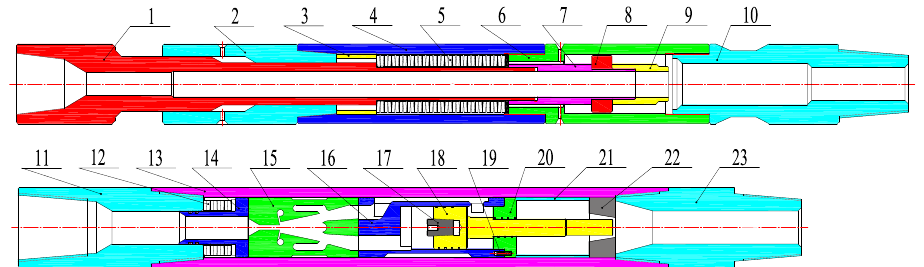
Figure 1. Schematic diagram of a fluidic axial oscillation tool [18]. 1–Mandrel, 2–Top tie ‐ in of axial oscillation assembly, 3–Inner sleeve of axial oscillation assembly, 4–External sleeve of axial oscillation assembly, 5–Disc springs, 6–Middle tie ‐ in of axial oscillation assembly, 7–Middel tie ‐ in of mandrel, 8–Step seal, 9–Bottom tie ‐ in of mandrel, 10–Bottom tie ‐ in of axial oscillation assembly, 11–Top tie ‐ in of pressure pulsation assembly, 12–Disc springs, 13–External sleeve of pressure pulsation assembly, 14–Gland, 15–output ‐ fed bistable fluidic oscillator, 16–Cylinder, 17–Adjusting rod, 18–Piston, 19–Dowel pin, 20–Cylinder lid, 21–Inner sleeve of pressure pulsation assembly, 22–Throttle plate, and 23–Bottom tie ‐ in of pressure pulsation assembly.